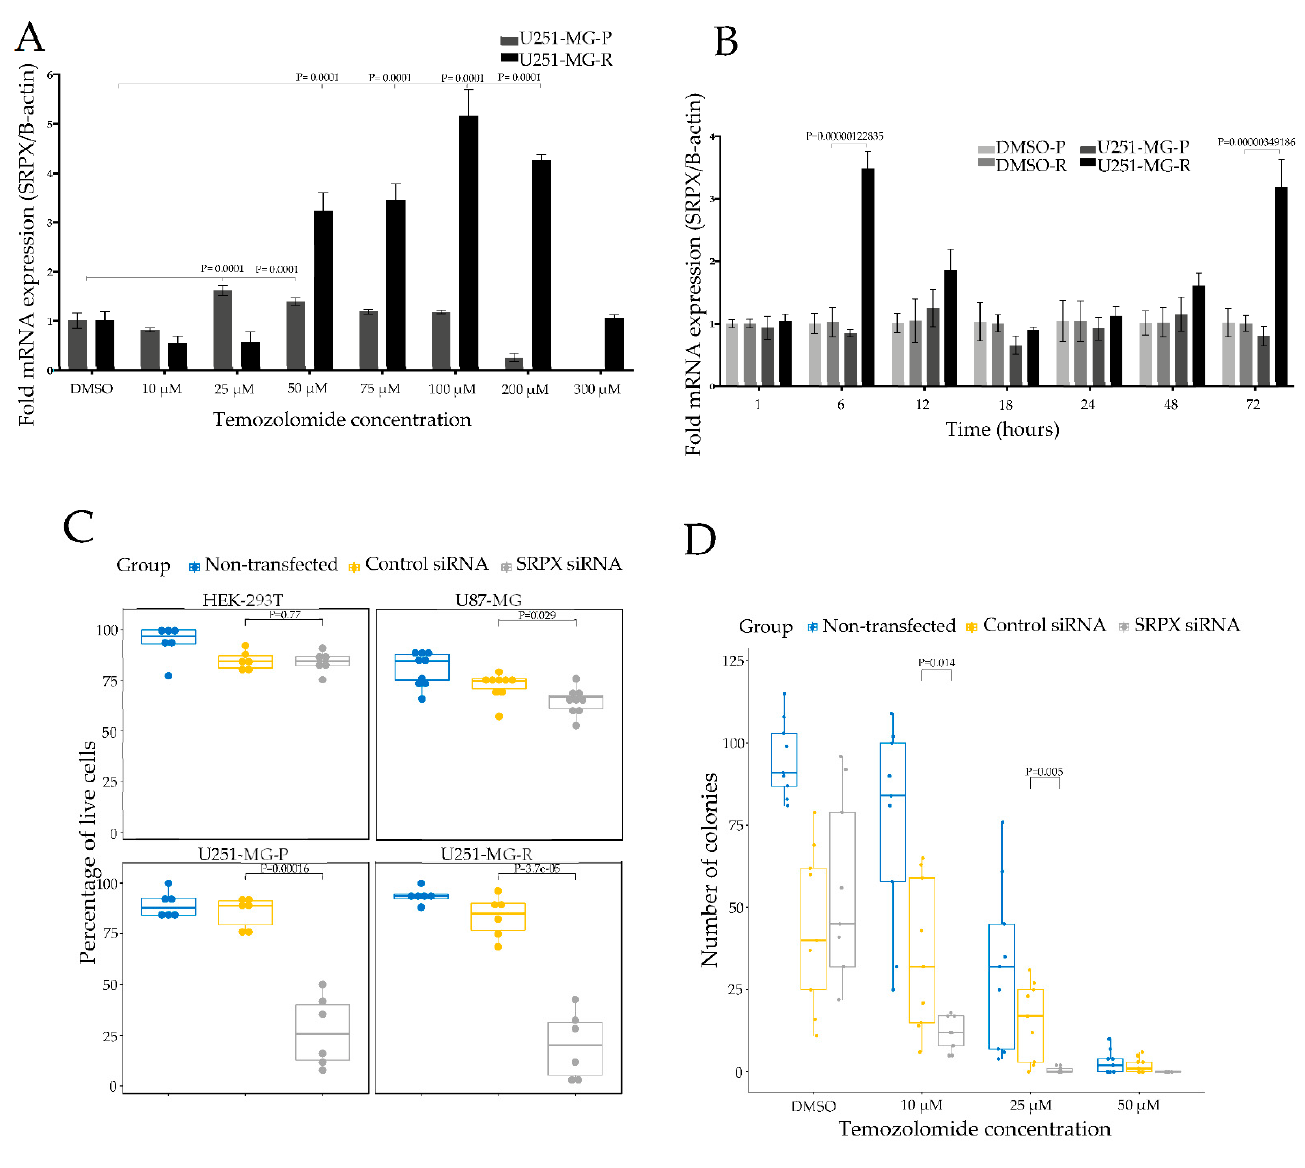
Figure 4. Association of SRPX with TMZ resistance in glioblastomas. ( A ) The mRNA expression levels of SRPX at increasing concentrations of TMZ, and ( B ) at different time intervals. Relative expression analysis was performed using the ∆∆ Cq method and gene expression was normalized to hB-actin. Error bars indicate means ± SEM and p -values indicate significance compared to the